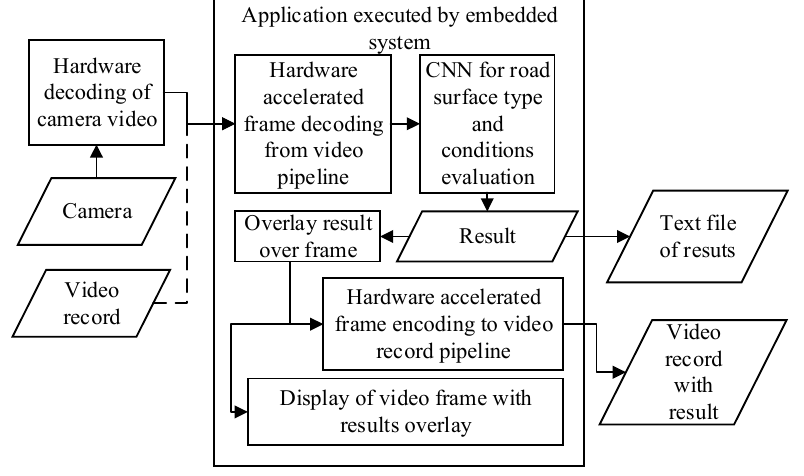
Figure 2. Blocks schematic of system implementation.